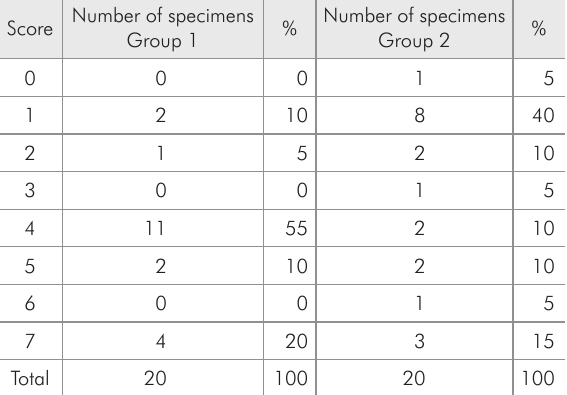
Table 1 - Number of specimens and their scores/percent- age based on the site of residual filling material in Group 1 and Group 2. Number of specimens Score Group